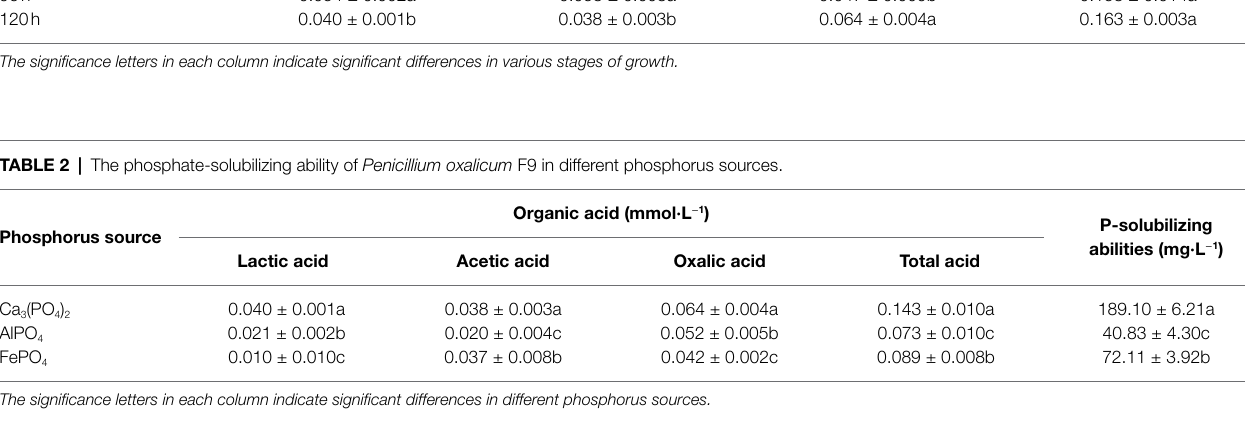
Duration of growth